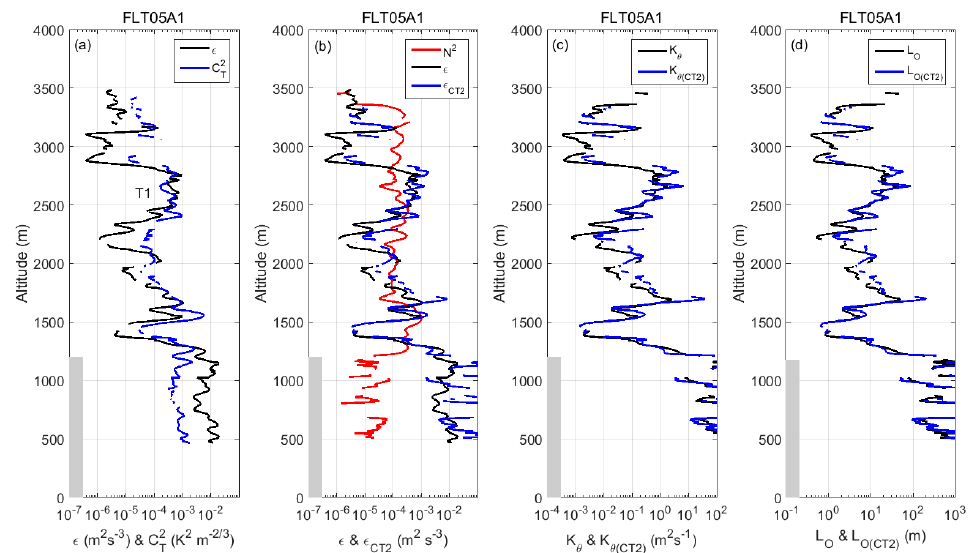
Figure 9. Vertical profiles of ( a ) 𝐶 (cid:3021)(cid:2870) (blue) and 𝜀 (black), ( b ) 𝜀 (black), 𝜀 (cid:3004)(cid:3021)(cid:2870) (blue) and 𝑁 (cid:2870) (red), ( c ) 𝐾 (cid:3087) (black) and 𝐾 (cid:3087)((cid:3004)(cid:3021)(cid:2870)) (blue), ( d ) 𝐿 (cid:3016) (black) and 𝐿 (cid:3016)((cid:3004)(cid:3021)(cid:2870)) (blue), for FLT05A1. The gray shaded areas show the CBL depth. “T1” refers to a turbulent layer discussed in the text.